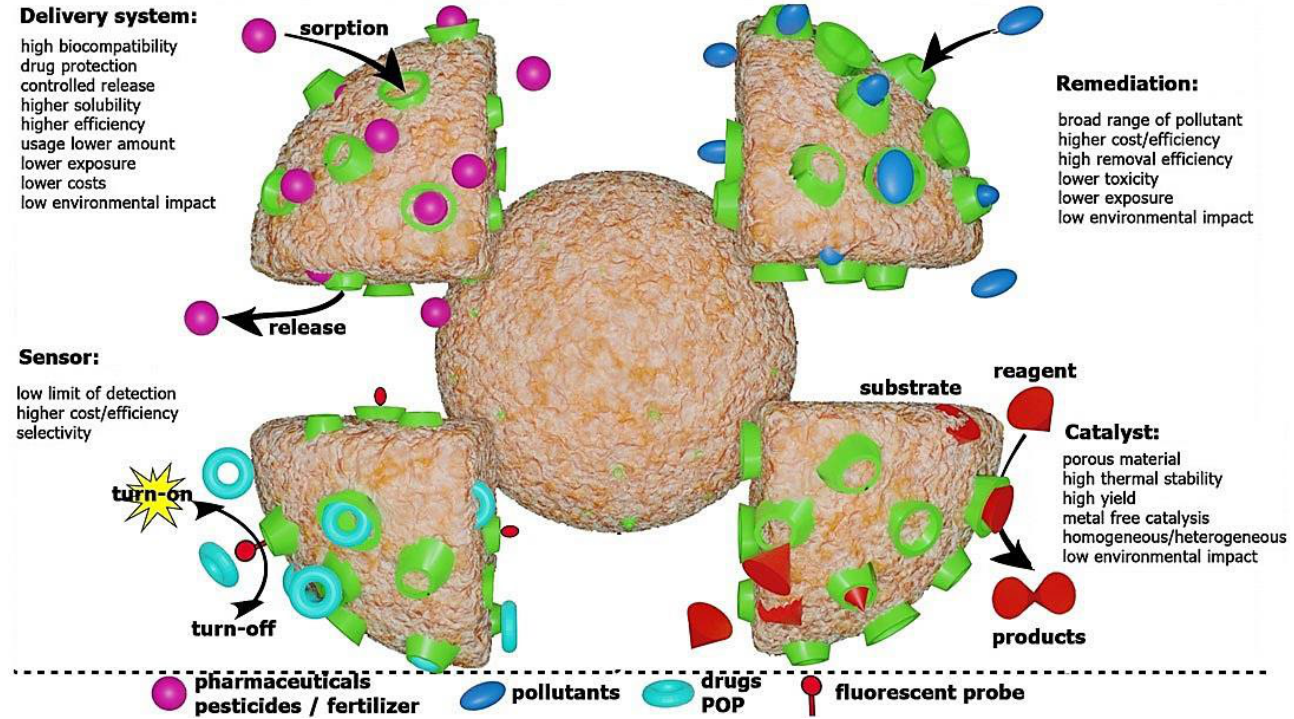
Figure 1. Cyclodextrin-based nanosponges with their advantages and applications. Adapted from [12] with permission. Copyright 2022 Frontiers (CC BY 4.0).